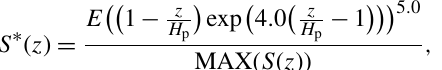
Figure 1. Schematic of the setup with the coupling between the global ICON-ART model and the 1D plume rise model